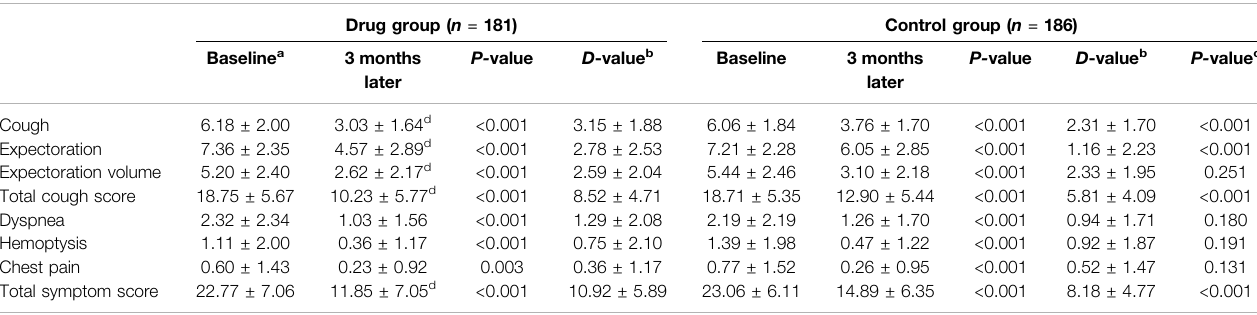
TABLE 2 | Comparison of clinical symptom